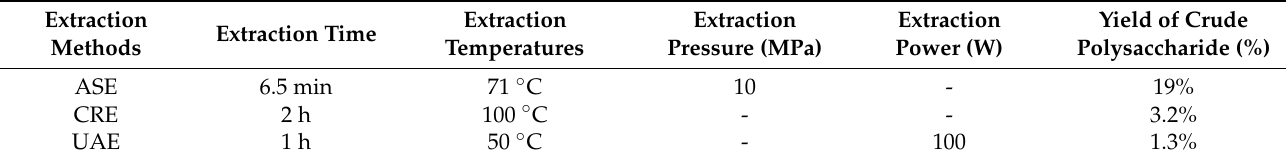
Table 1. Yields of crude polysaccharide with different extraction